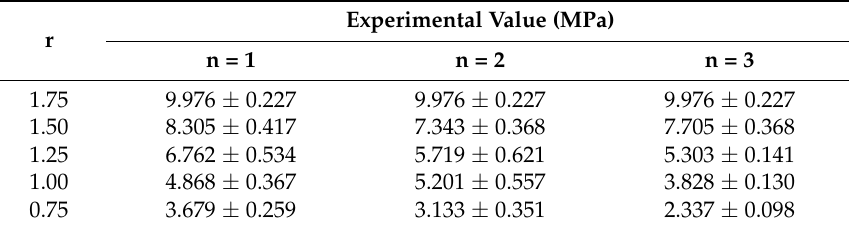
Table 4. Experimental values of the equivalent compressive elastic modulus.